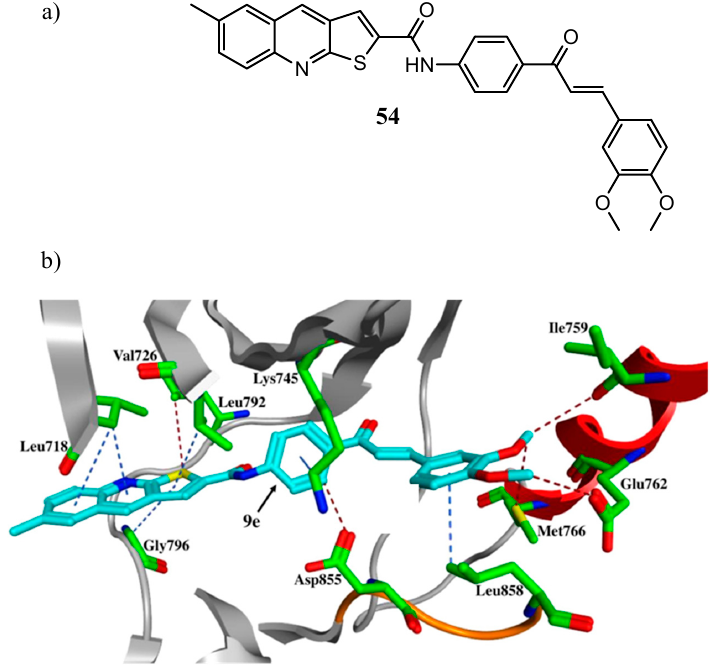
Figure 26. ( a ) Thieno[2,3- b ]quinoline-2-carboxamide-chalcone derivative 54 ; ( b ) orientation and interactions of 54 within the EGFR active site [124].